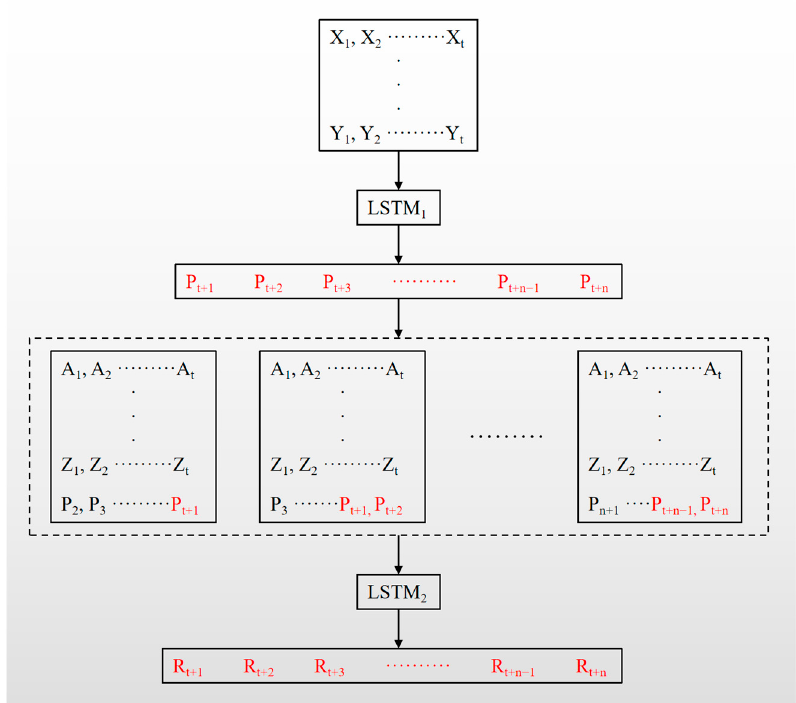
Figure 2. The setting of the cascade LSTM model.